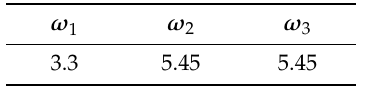
Table 6. Bus order chain.